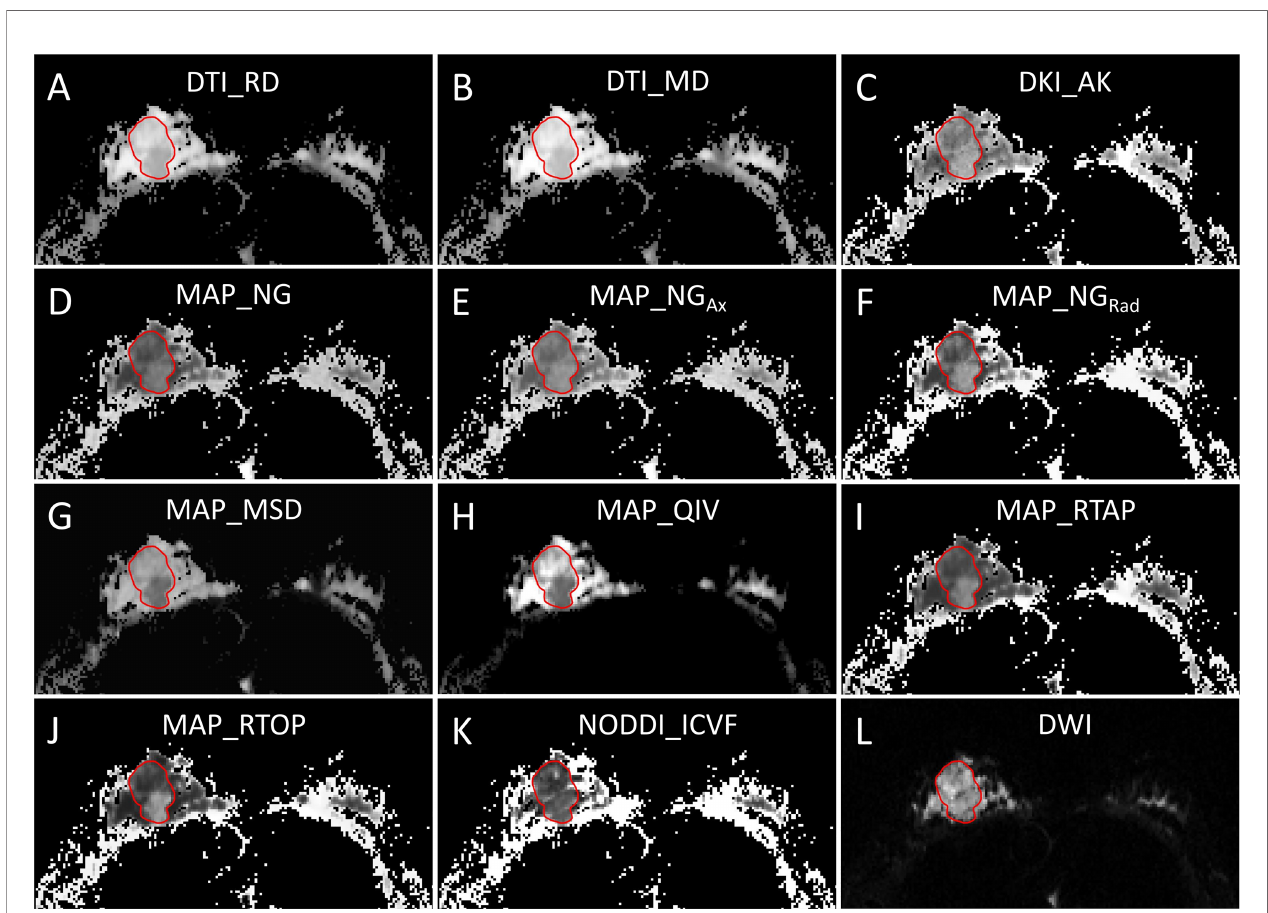
FIGURE 3 | A 42-year-old woman with pathologically con fi rmed human epidermal growth factor receptor 2 (HER2)-positive breast cancer in the right breast. (A – K) Diffusion spectrum imaging (DSI) quantitative parameter measurements and (L) diffusion-weighted imaging (DWI)